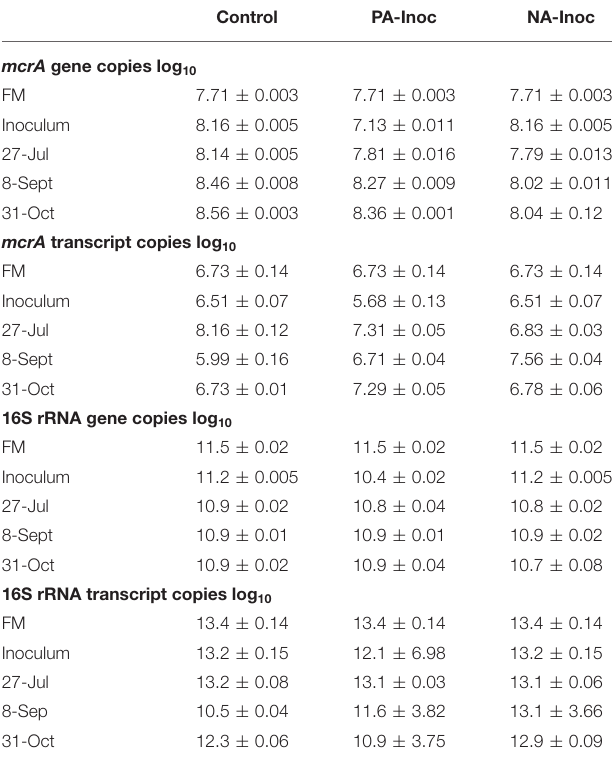
TABLE 5 | Copies (log 10 ) of mcr A and 16S rRNA gene and transcript from fresh manure (FM) and inoculum sampled on tank filling day (May 29, 2018), and from composite samples of stored manure on Jul 27, Sept 8, and Oct 31, 2018 from control (FM), newly acidified inoculum (NA-Inoc), and previously acidified inoculum (PA-Inoc)